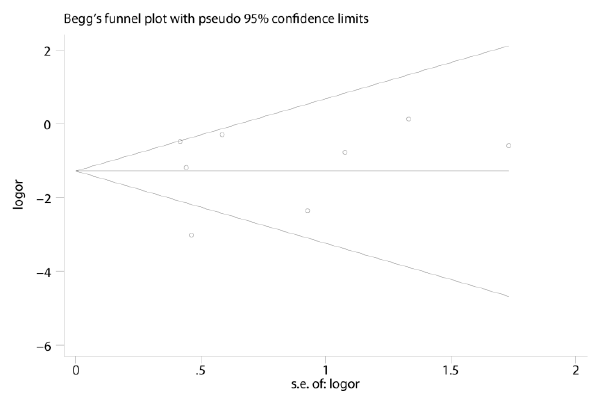
Figure 5. Begg’s funnel plot with pseudo 95% confidence limits.